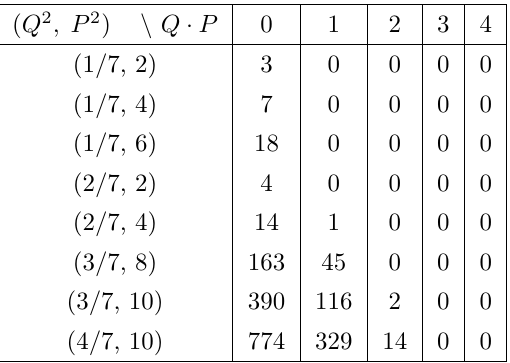
Table 12 . Index of horizon states for the 11A orbifold of K 3 .